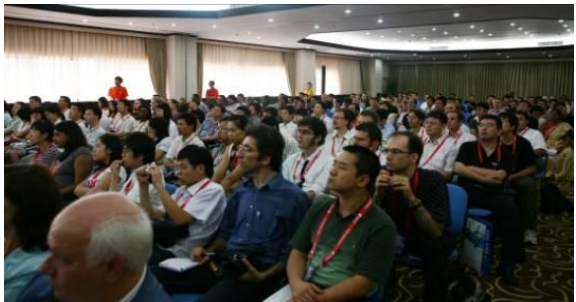
Figure 1. The White Elephants Session as a part of the YF in Beijing